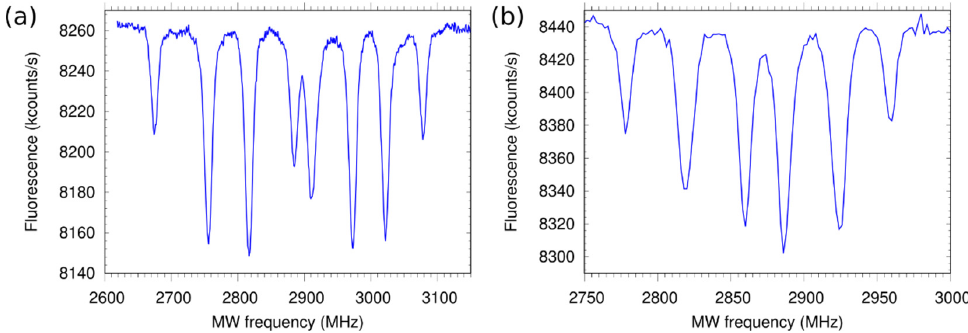
Figure 7. ODMR spectra of the NV centers in the ( a ) [100] and ( b ) [111] samples. The applied magnetic field is B 0 [100] = 36.5 G and B 0 [111] = 32.5 G, respectively. The different contrast of the transitions is probably due to varying microwave field for different crystal orientations of the NVs. The bulk structures show similar ODMR spectra (data not shown).